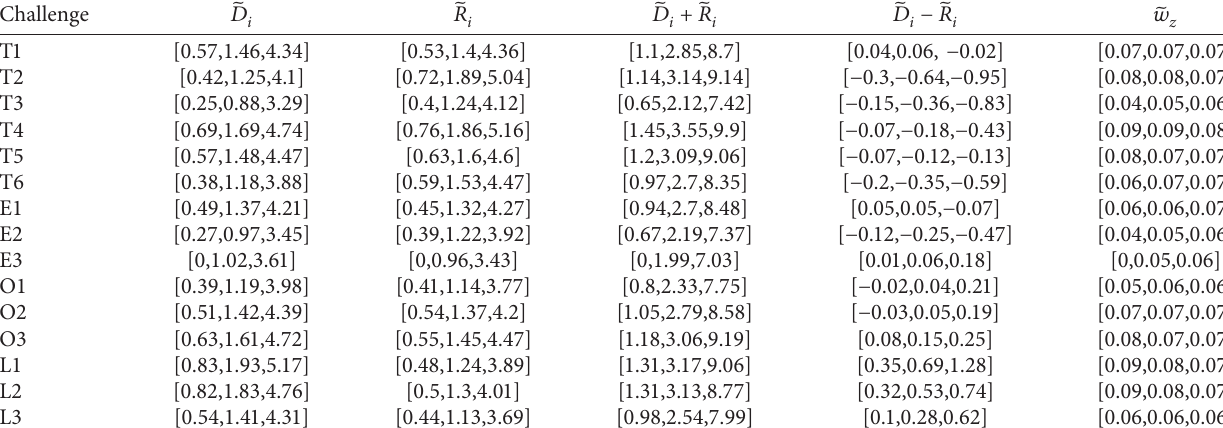
− 􏽥 R , 􏽥 D + 􏽥 R , 􏽥 D , 􏽥 R , and 􏽥 w i i i i i i